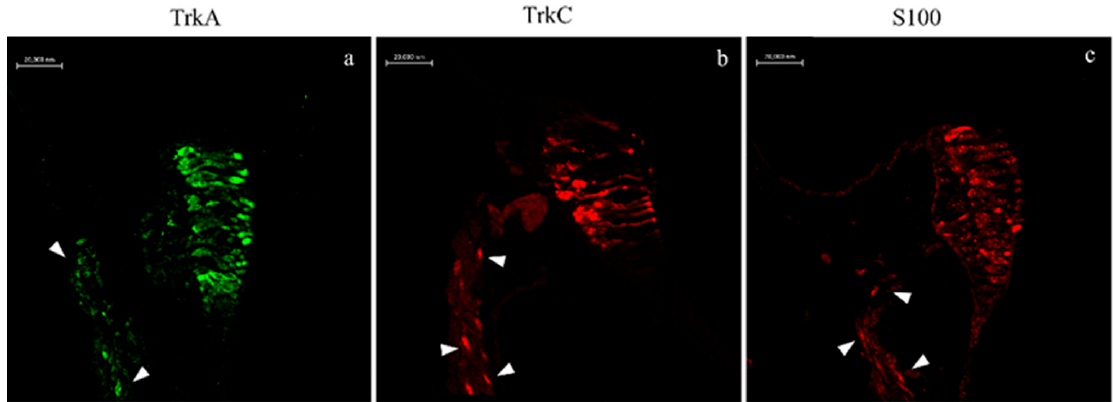
Figure 6. N.guentheri inner ear; transversal view. Immunohistochemical detection (immunofluorescence method) of TrkA ( a ), TrkC ( b ), and S100 protein ( c ) in sensory hair cells of the cristae ampullaris. The cristae ampullaris in the apical portion contain sensory hair cells, supporting cells, and basal cells. Arrowheads ( a – c ) indicate nerves. Magnification 40 × .